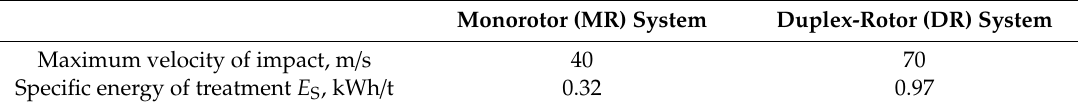
Figure 9. Schematic representation of centrifugal accelerator (disintegrator DSL-178). ( a ) Mono-rotor (MR) system; ( b ) Duplex-rotor (DR) system, SF-side feed, 1–3 treatment rings with grinding elements. Table 2. Maximum velocity of impact and specific energy of treatment E S of treated material in